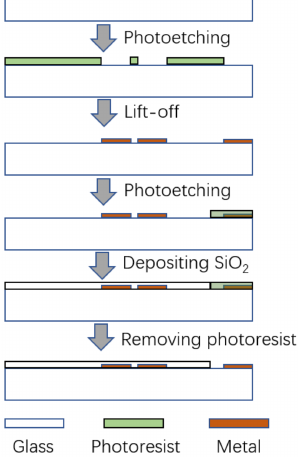
Figure 3. Fabrication process.